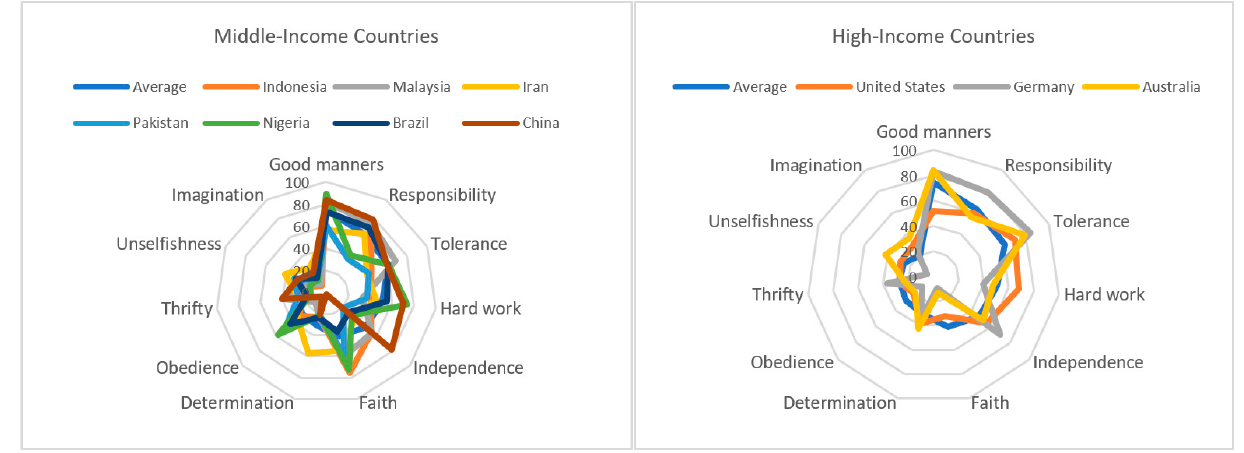
Figure 8. Qualities to develop for future generation by Economic status.